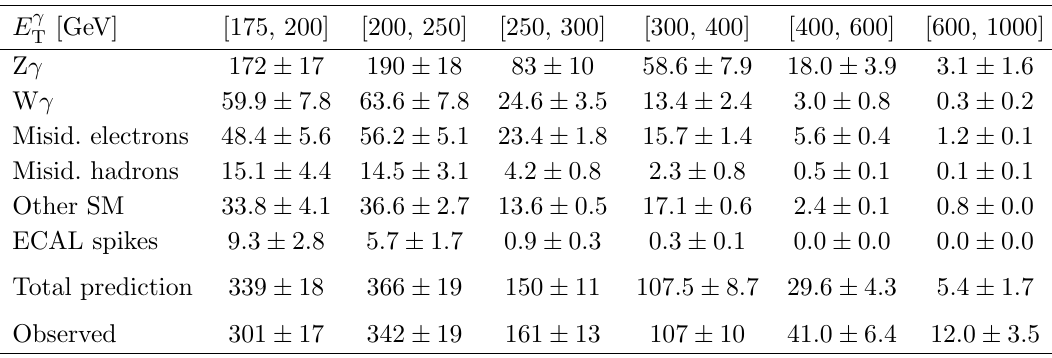
Table 2 . Expected event yields in each E (cid:13) bin for various background processes in the vertical signal T region. The background yields and the corresponding uncertainties are obtained after performing a combined (cid:12)t to data in all the control samples, excluding data in the signal regions. The observed event yields in the vertical signal region are also